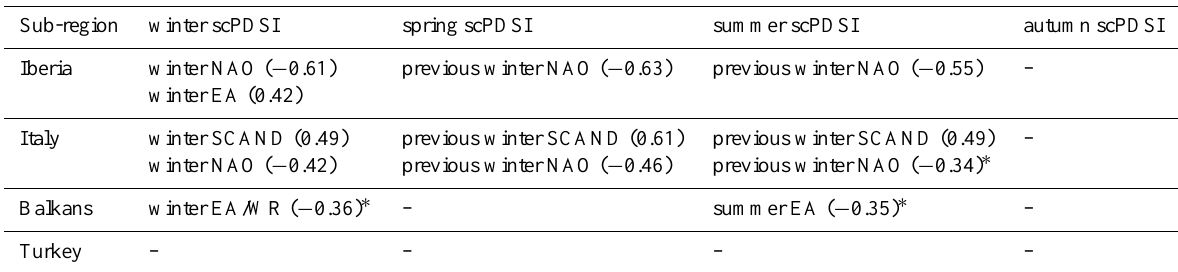
Table 4. Summary of the large-scale atmospheric indices presenting significant correlation coefficient values (at the 5% level) with the seasonal scPDSI for each considered sub-region, for non-lagged, 3-month and 6-month lagged series. Values marked with ( ∗ ) only achieve the 10% level of statistical significance. All time series were detrended.